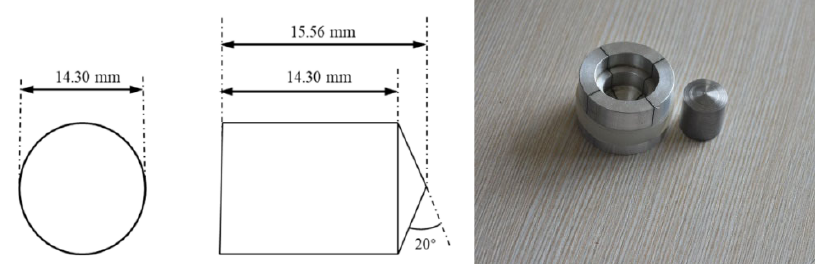
Figure 2. Size and shape of experimental projectile.